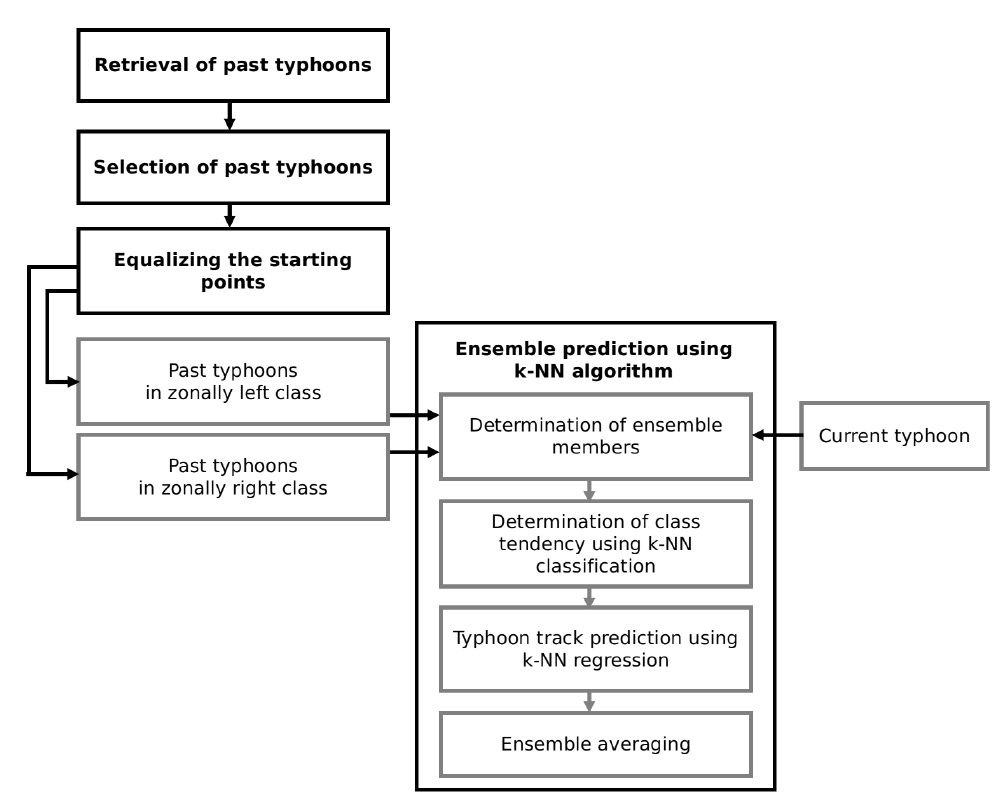
Figure 1. The schematic workflow of regional typhoon track prediction using ensemble k-NN in the context of the GIS